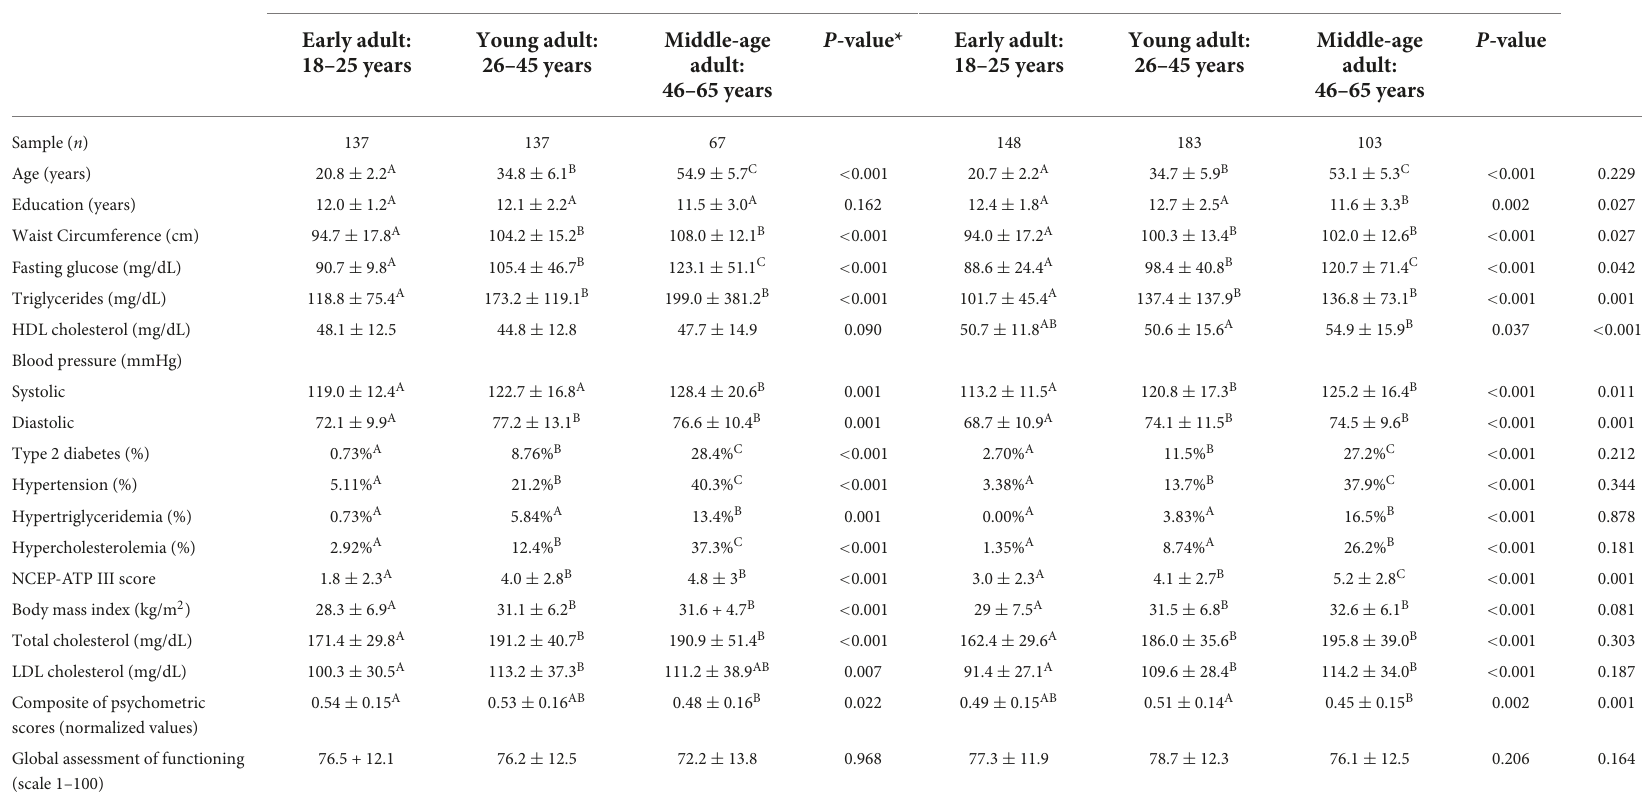
TABLE 1 Group demographic data and health characteristics (mean ±